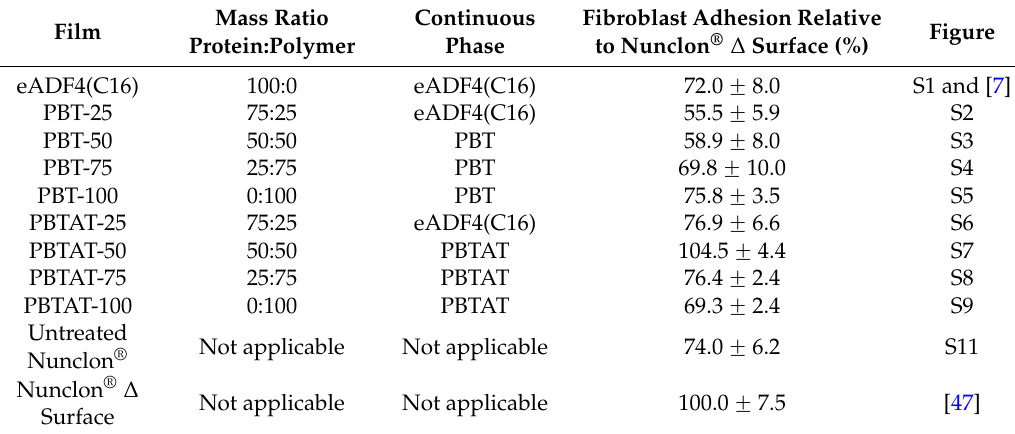
Table 1. Film compositions and properties. PBTAT, poly(butylene terephthalate- co -poly(alkylene glycol)